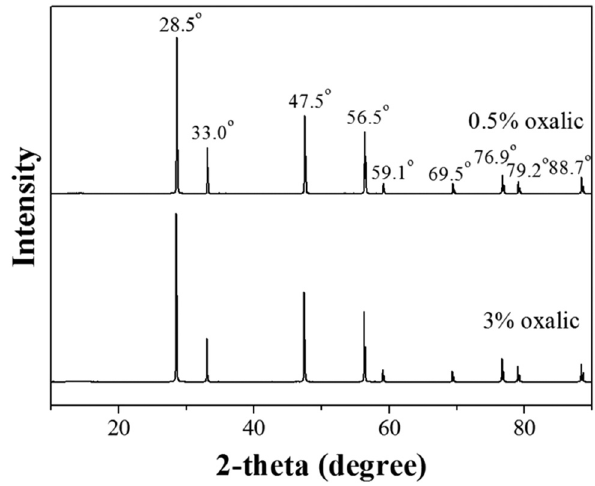
Figure 1: XRD patterns of CeO 2 synthesized using 0.5% and 3% oxalic concentration at 400 rpm stirring rate.